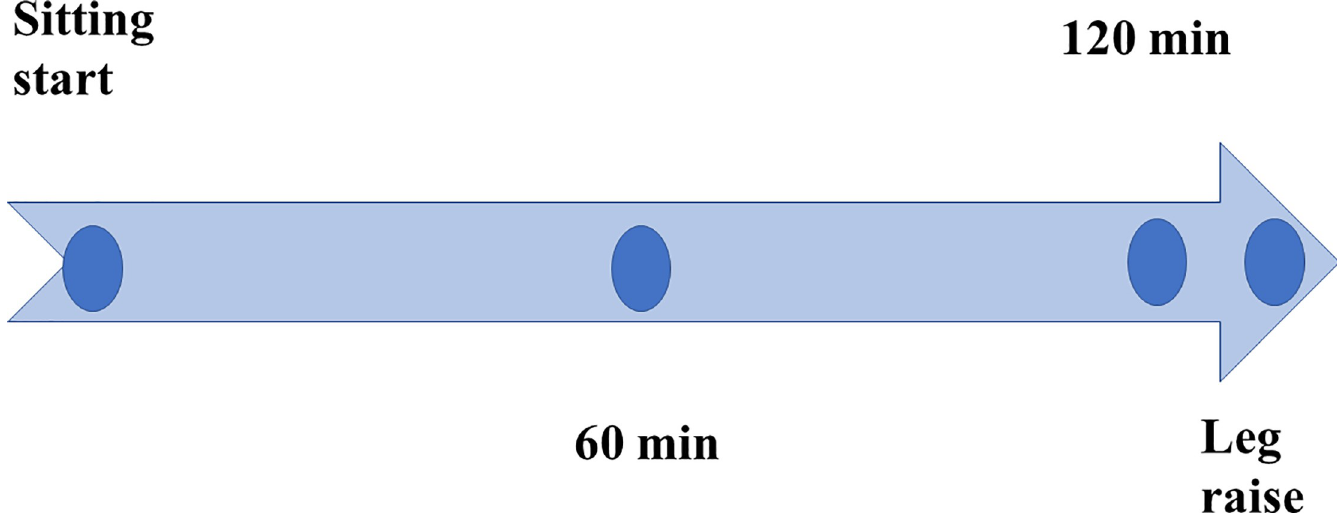
Fig 1. Experimental design. https://doi.org/10.1371/journal.pone.0251532.g001 Measurement of shear wave velocity. Shear wave velocity was measured as an indicator of muscle stiffness. We used an ultrasound system (Aplio 500, Canon, Tokyo) and a linear probe (PLT100BT5, Canon, Tokyo) with a field view of approximately 58 mm, standard oper- ating frequency of 10 MHz (up to 14 MHz). The accuracy of the velocity measurement by Aplio500 using a phantom (CIRS, Norfork, Virginia, USA; model 049 and 049A) of 8.0 ± 3.0 kPa is 0.49 kPa, and the precision (Coefficient of Variation and Confidence Interval) is 6.96%, 5.79–8.13%. The accuracy and precision of the velocity measurements from 2 to 6 cm material depth are not different [18]. The range of measurement of the shear wave velocity of the leg muscles in this study by Aplio500 was 1.0–3.0 m/s (3.0–9.0 kPa), and the depth of the soleus muscle at the deepest point was about 4.0 cm, so the reliability of the measurement of the shear wave velocity of the leg muscles by Aplio 500 was assured. The measured muscles were the medial and lateral gastrocnemius, soleus and tibialis ante- rior. The location of a probe to be applied on the muscle belly of the medial and lateral gastroc- nemius, soleus and tibialis anterior muscles was adjusted in the designated position (the medial and lateral portions of the gastrocnemius muscle at 30% of the proximal left lower leg,